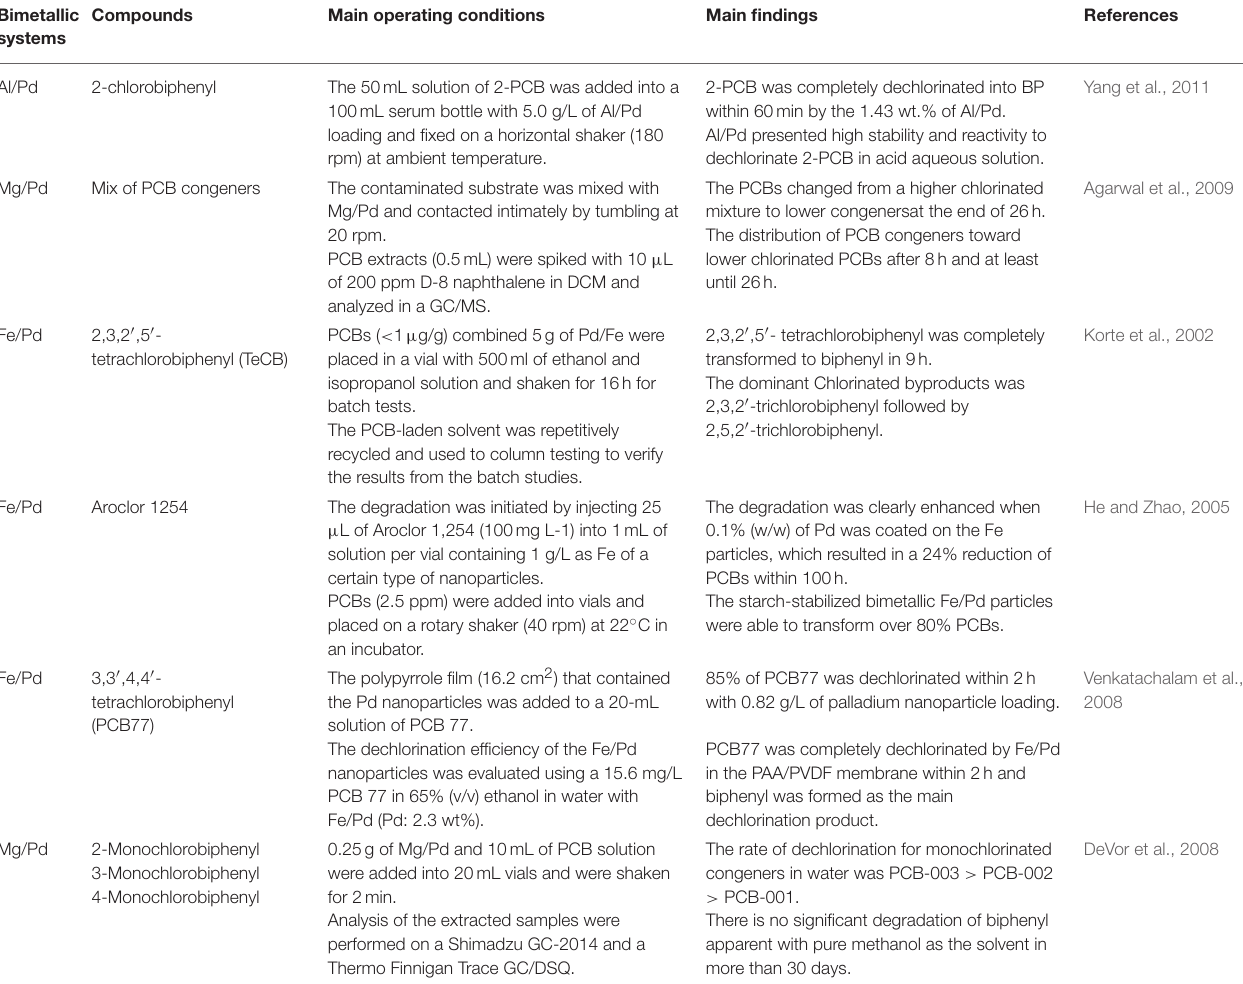
TABLE 2 | Summary of experimental conditions and main findings of studies on hydrodechlorination of PCBs by bimetallic